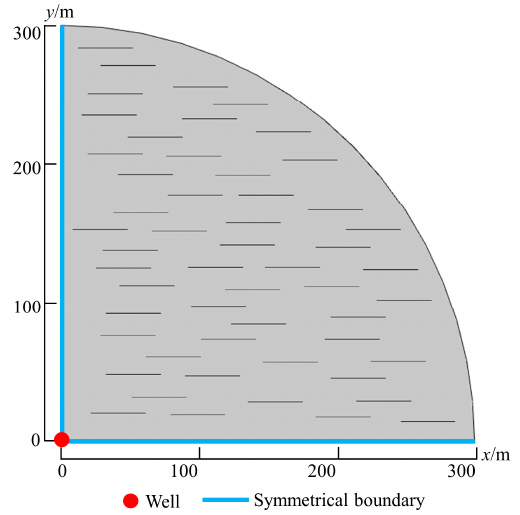
Figure 1. Formation model diagram.